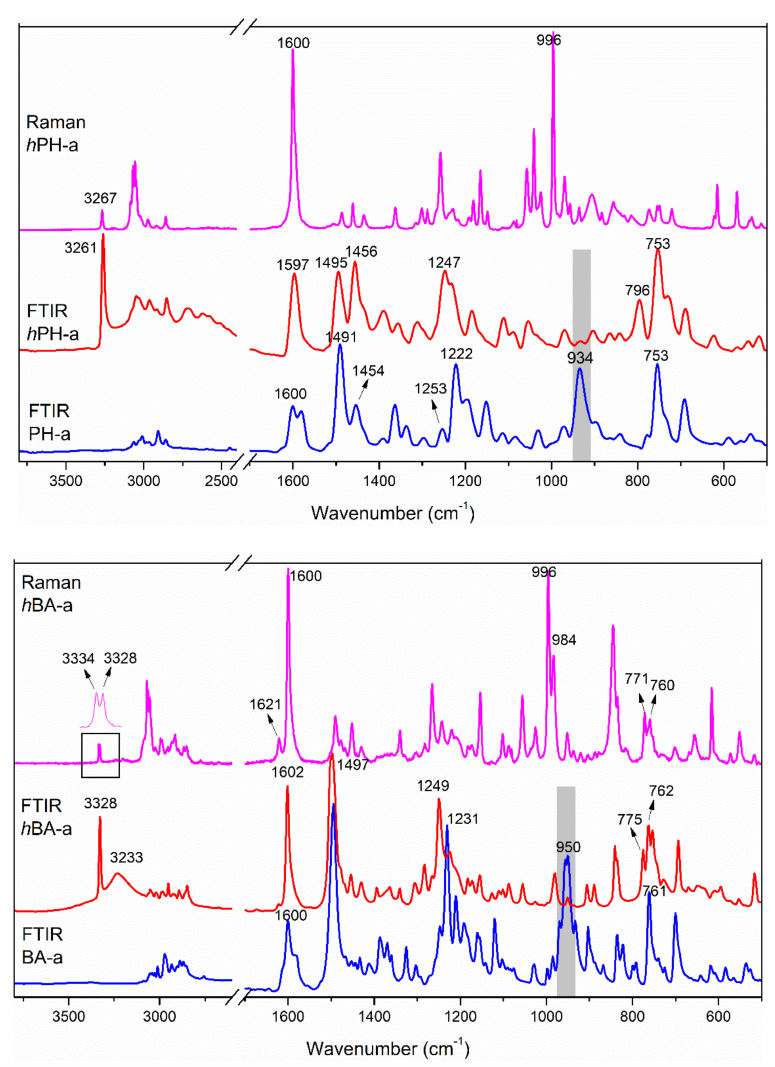
Figure 2. Raman and Fourier transform infrared (FTIR) spectra of h PH-a and PH-a, h BA-a and